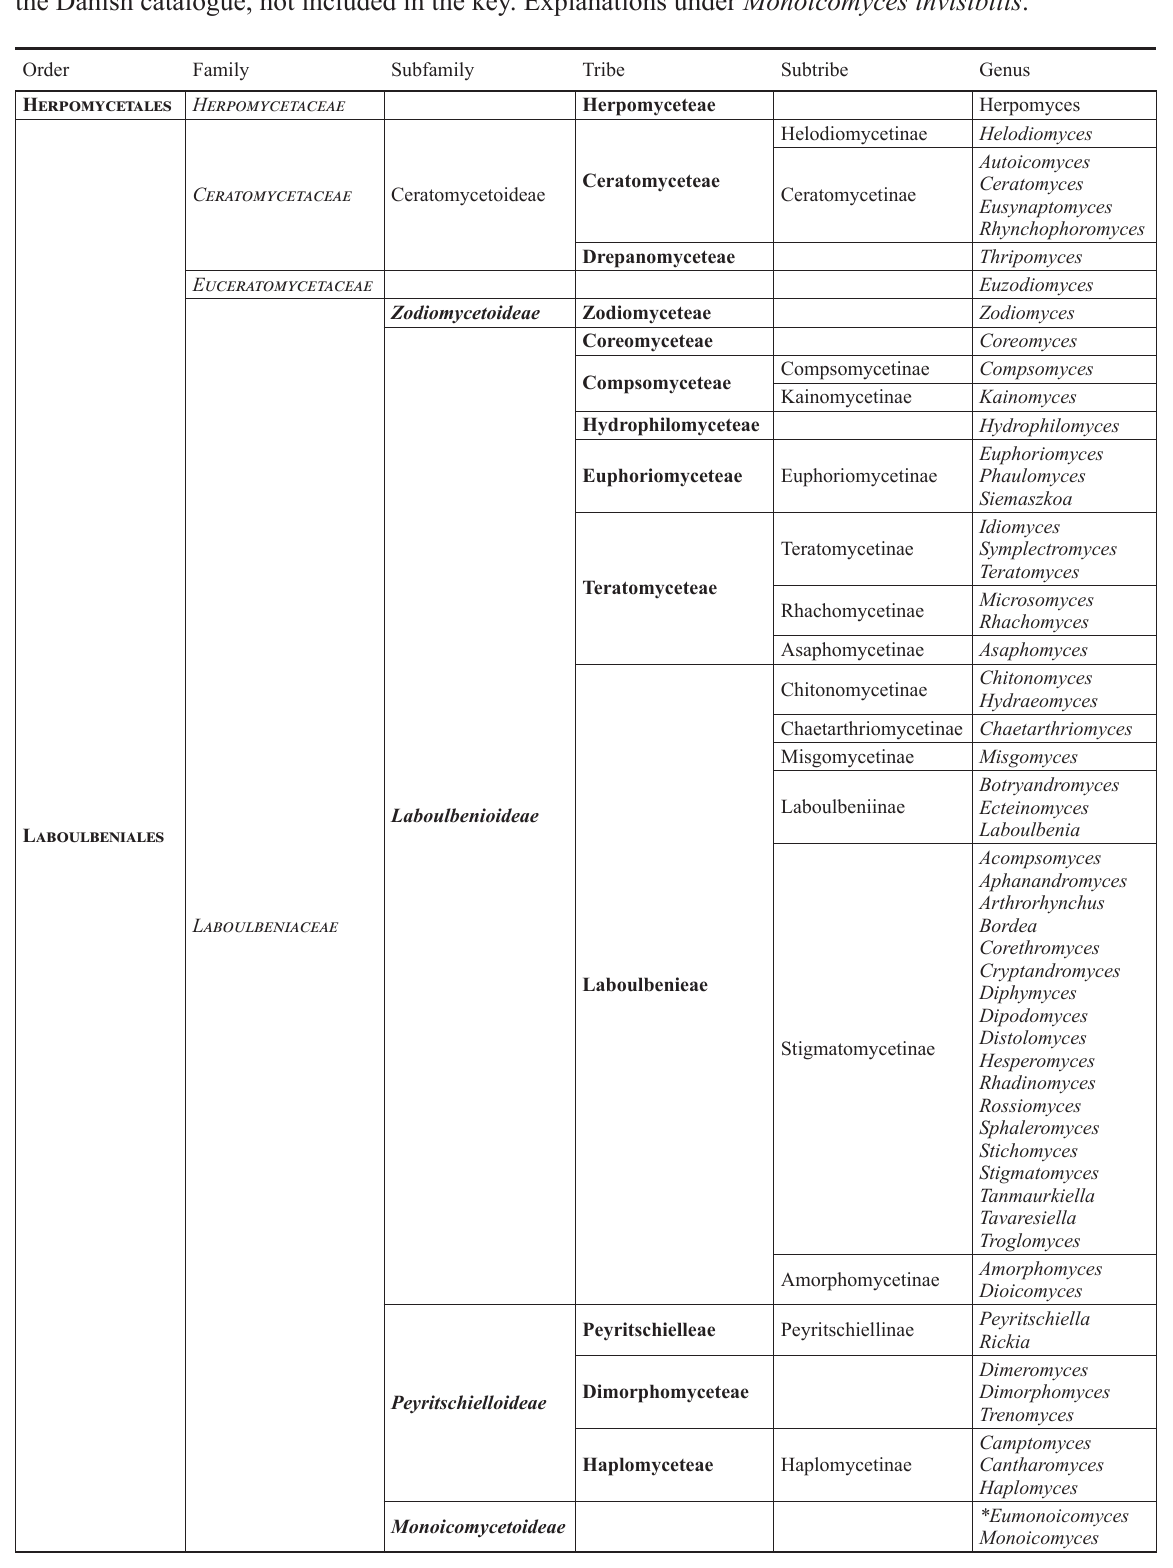
Table 2. Classification system of known Danish genera used in the text. * = genus to be removed from the Danish catalogue, not included in the key. Explanations under Monoicomyces invisibilis